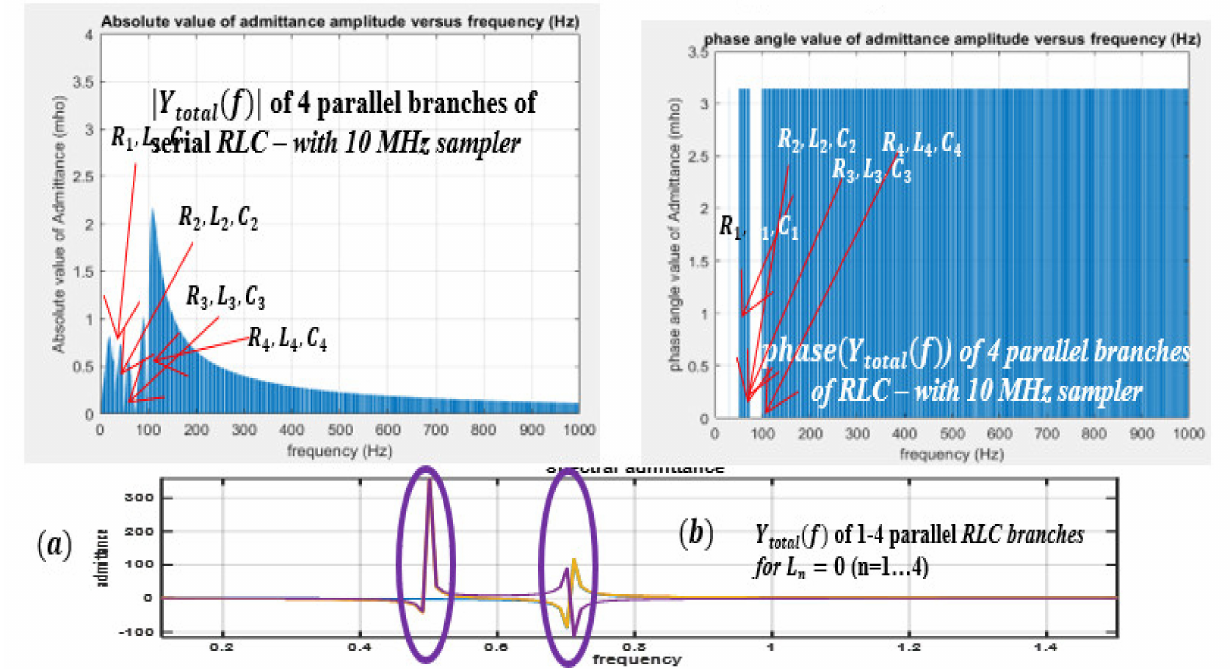
Figure 12. Admittance function simulated results ( a ) | Y total ( f ) | . ( b ) phase ( Y total ( f )) . ( a ) + ( b )—4 parallel branches of serial (cid:0) (cid:1) RLC. ( c ) the function of ∑ n − ω C n / 1 + C n R n ω 2 for n = 1, . . . ,4 various R n , C n ( L n = 0 )